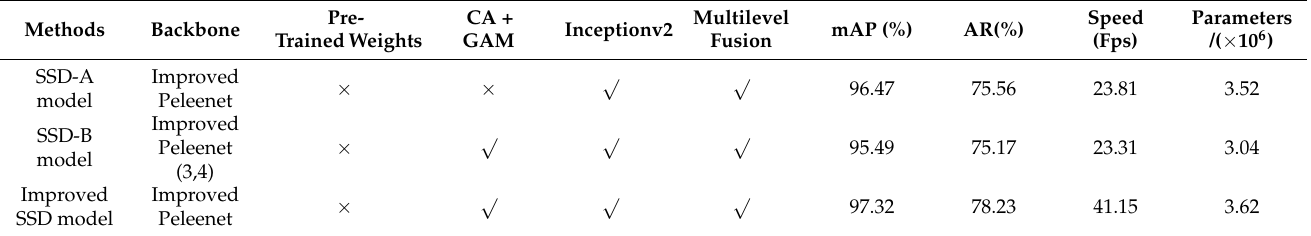
Table 2. Improved Peleenet network comparison experiment evaluation indicators